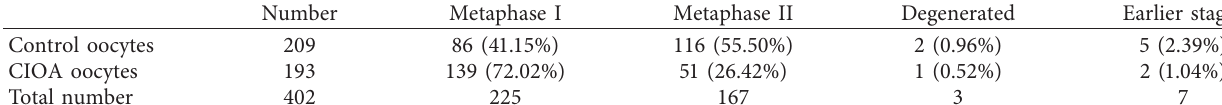
Table 1: Absolute numbers and (in brackets) proportions of oocytes of each category.